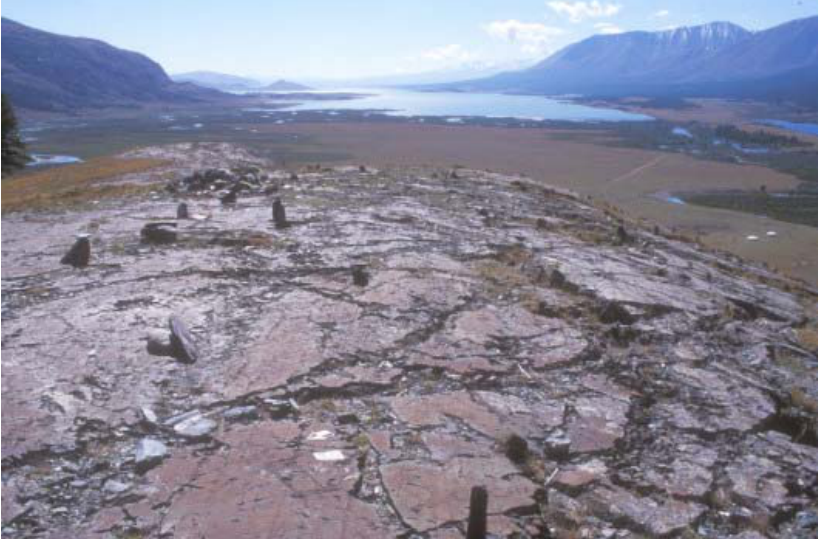
Figure 18. Shattered bedrock surface at the top of Aral Tolgoi. View to the east, toward Khoton